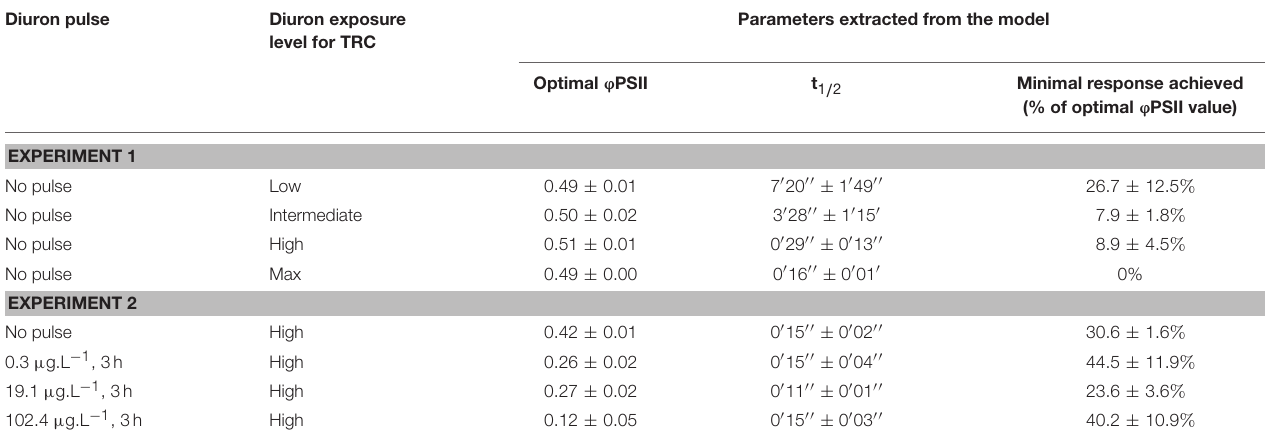
Parameters extracted from the